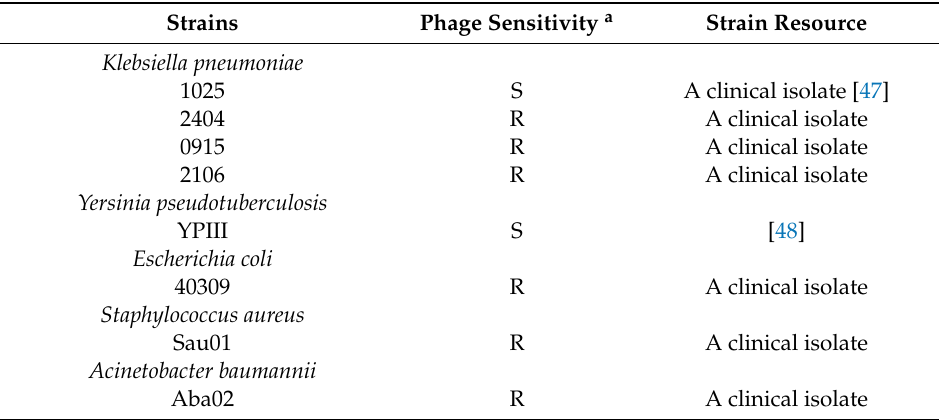
Table 1. Host range of the vB_KleS-HSE3 phage.